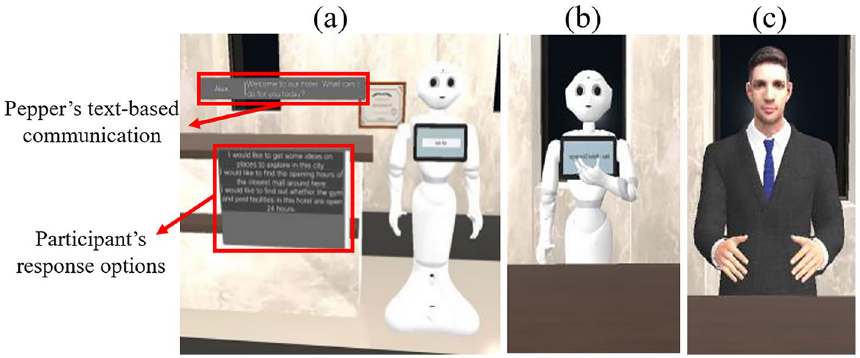
Figure 1. Service robots with three different levels of anthropomorphism. ( a ) Pepper robot communicating with text, ( b ) Pepper robot communicating with voice and gestures, ( c ) android communicating with human- like voice, gestures and appearance.